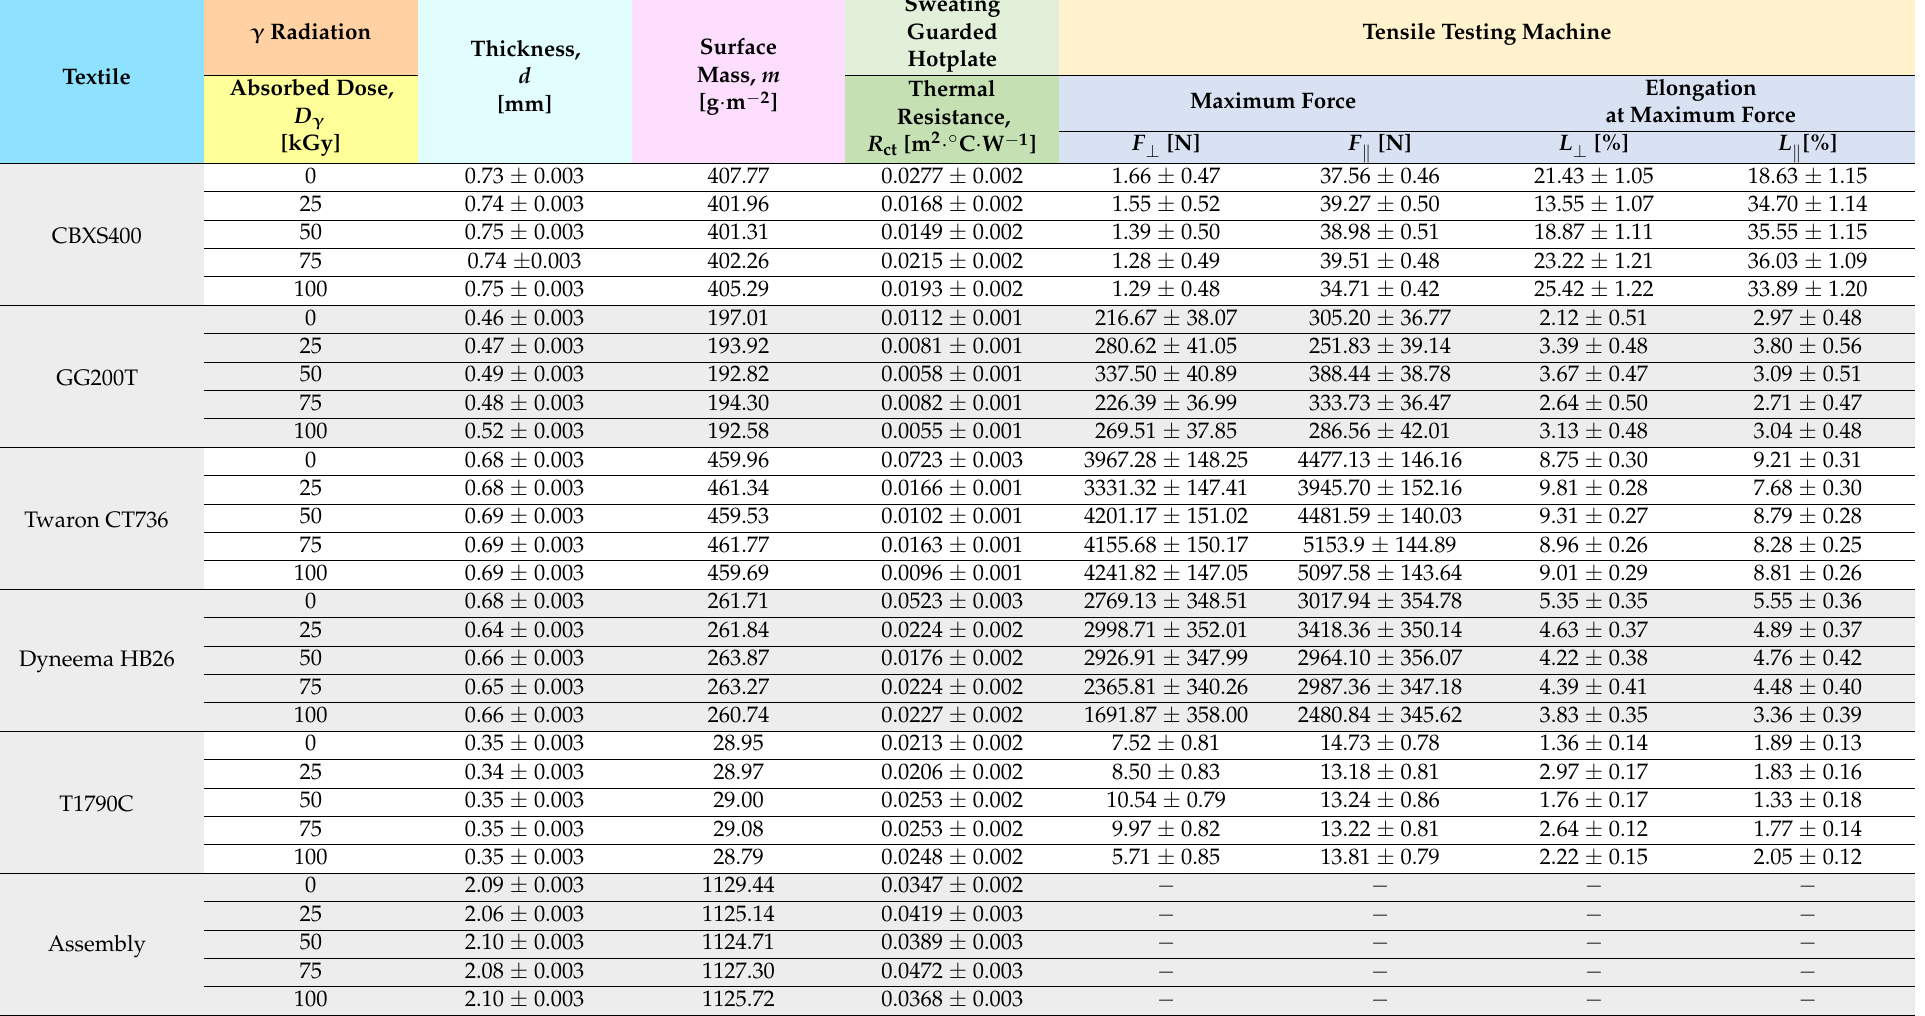
Table 6. Structural, biophysical and mechanical properties of unmodified and γ -irradiated